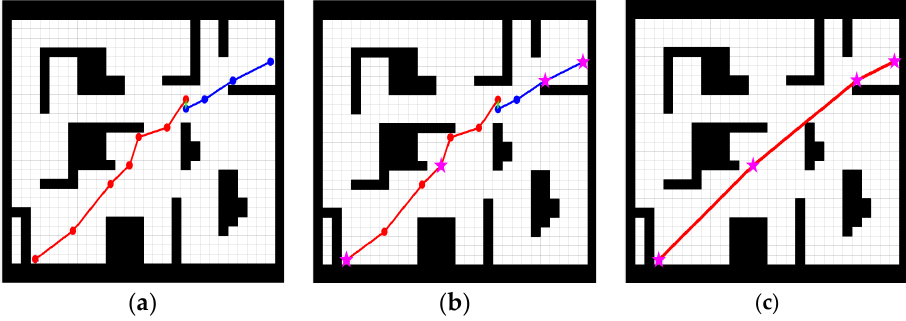
Figure 9. Optimization steps. ( a ) Original path, ( b ) Extraction of key nodes, ( c ) Final Path.